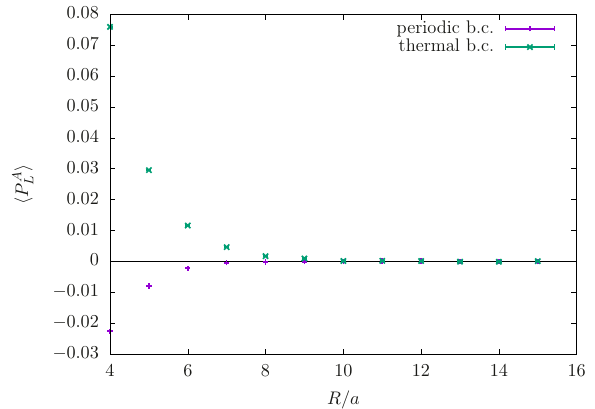
Figure 11 . Polyakov loop in the adjoint representation as a function of the compactification radius for periodic boundary conditions with the same parameters as in figure